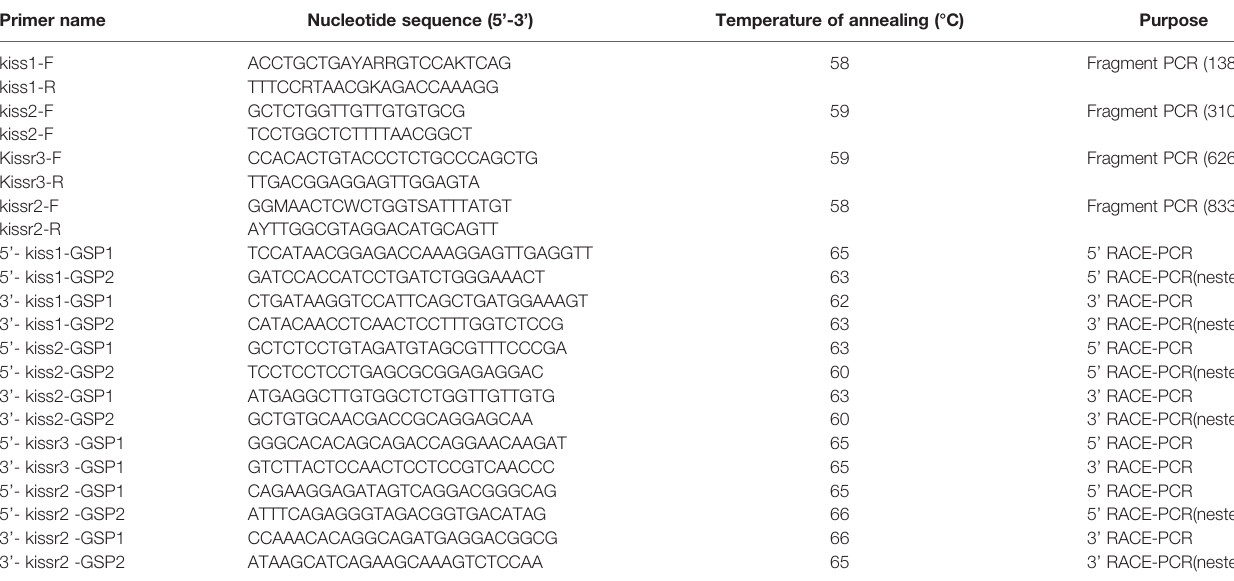
TABLE 1 | List of primers used for molecular cloning of kiss and kissr